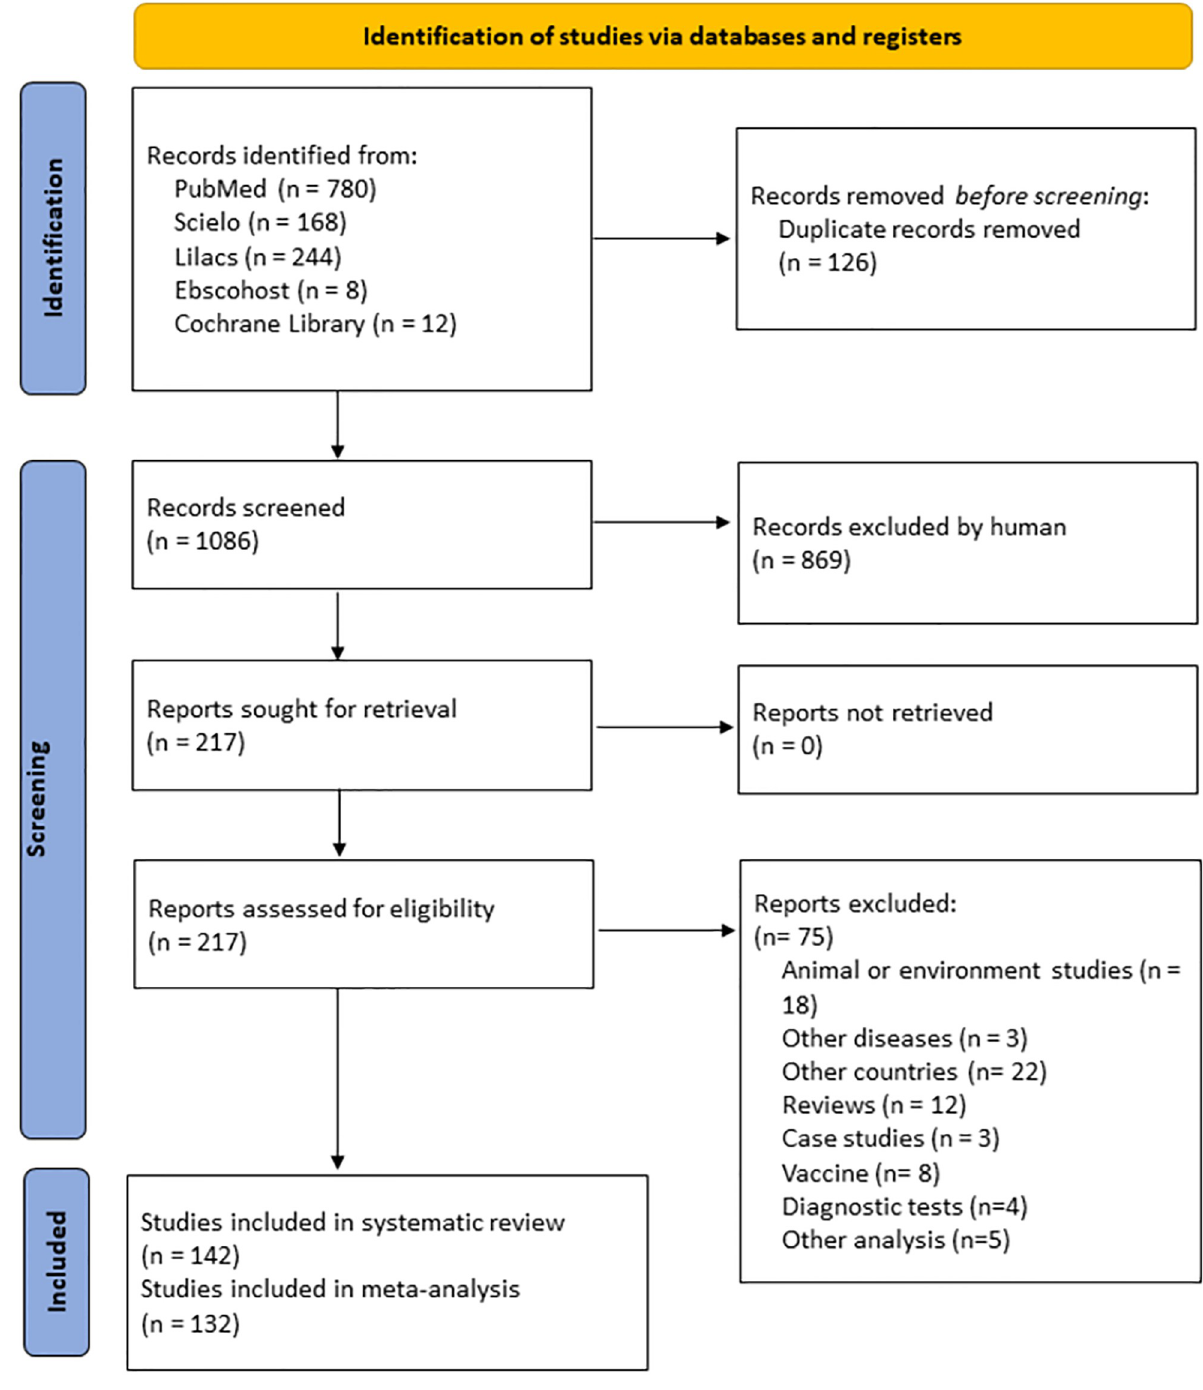
Fig 1. Flow diagram of the selected studies for the HEV seroprevalence.